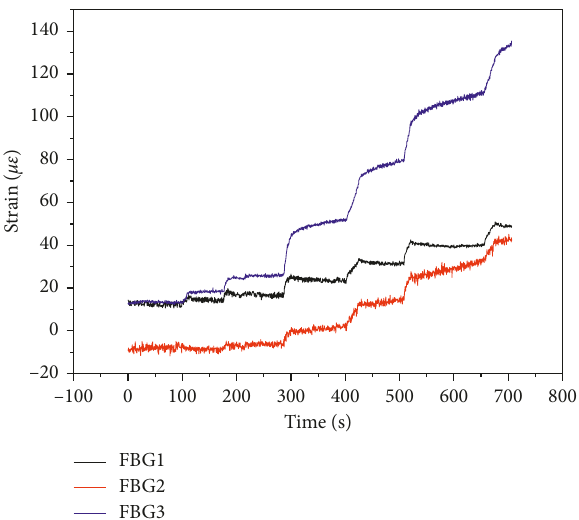
Figure 11: (a) First-order difference time series. (b) AR (3) smoothing sequence of FBG 3 sensor.